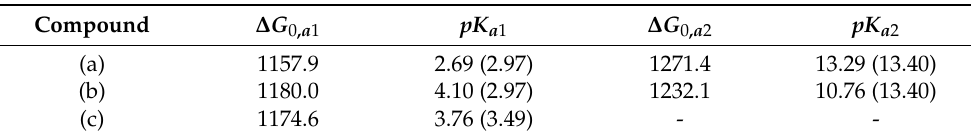
Table 1. Deprotonation Gibbs energy (in kJ/mol) and estimated p K a in each conformer of salicylic acid. Numbers in parentheses indicate experimental values.